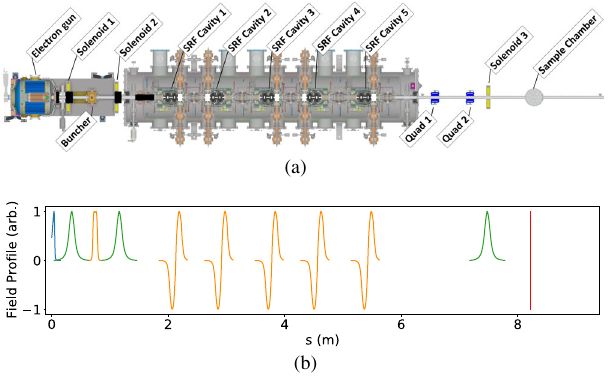
FIG. 1. (a) 3D model of the apparatus. (b) Electric and magnetic field profiles along the beamline. The dc gun field is shown in blue, solenoid fields in green, rf cavities in orange, and the sample location is shown via a red